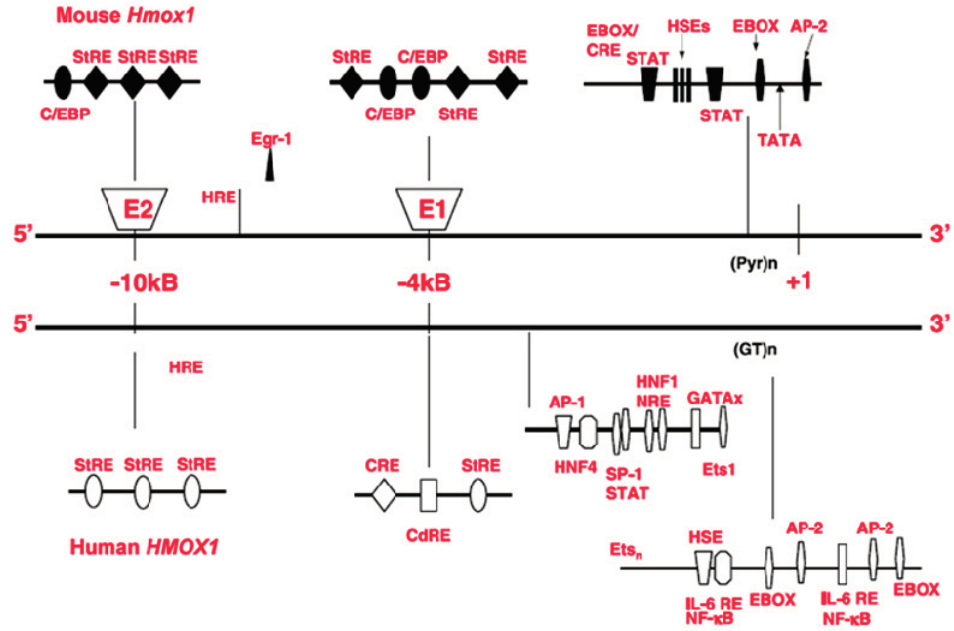
Figure 2. Regulatory domains of the mouse and human Hmox1 genes. AP-1, activator protein 1; AP-2, activator protein-2; CdRE, cadmium responsive element; C/EBP, CAAT/enhancer binding protein binding site; CRE, cAMP responsive element; egr1, early growth response factor-1 binding site; ets, ets binding site; GATAx, GATA binding proteins; (GT)n, GT-rich repeat region; HNF1/4, hepatocyte nuclear factor 1/4; HRE, hypoxia responsive element; HSE, heat shock element; NF- κ B, nuclear factor κ -B; NRE, negative regulatory element; (Pyr)n, pyrimidine-rich region; SP-1, specificity protein-1; STAT, signal transducer and activator of transcription; StRE, stress responsive element; TATA, TATA box; USF, upstream stimulatory factor. (Modified from [28], with